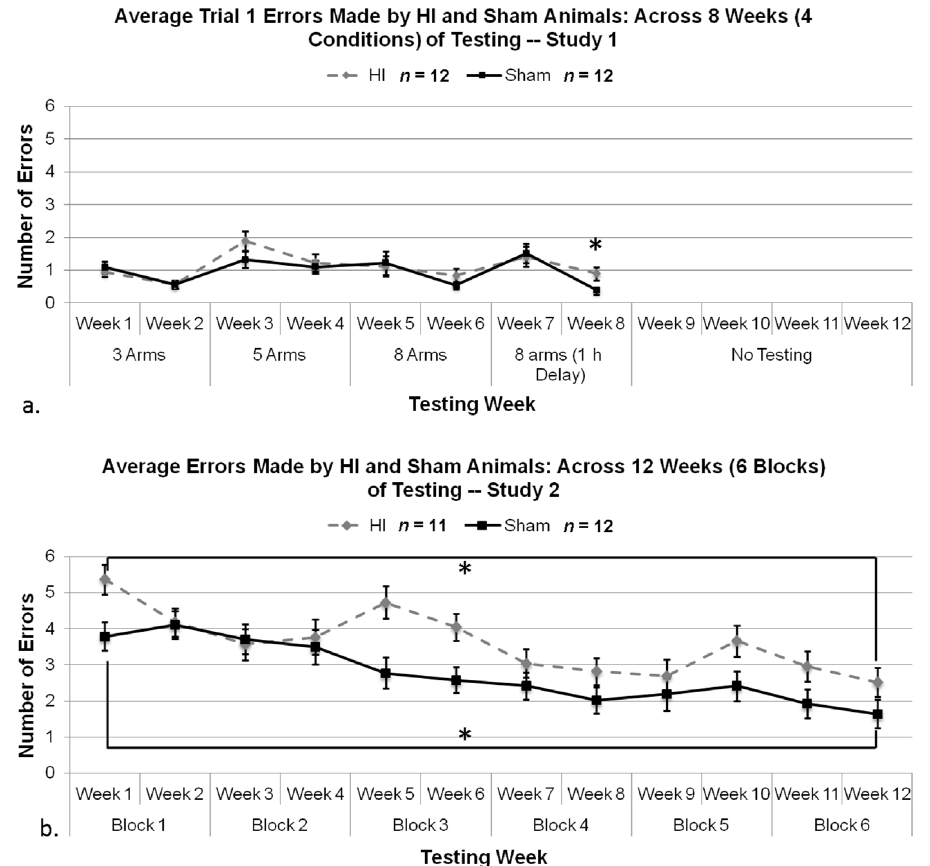
Figure 4. ( a ) A one tailed independent samples t -test using Tukey’s test to correct for multiple comparisons revealed a significant effect of Treatment (* p < 0.05) in Study 1, with HI animals making significantly more errors than sham animals on Week 8. ( b ) A repeated measures ANOVA revealed a significant overall Treatment effect on mean errors made ( p < 0.05), and paired samples t -test between Block 1 and 6 for HI (* p < 0.05) and sham animals (* p < 0.01) revealed significant differences in regards to average errors made in a test trial ( i.e. ,